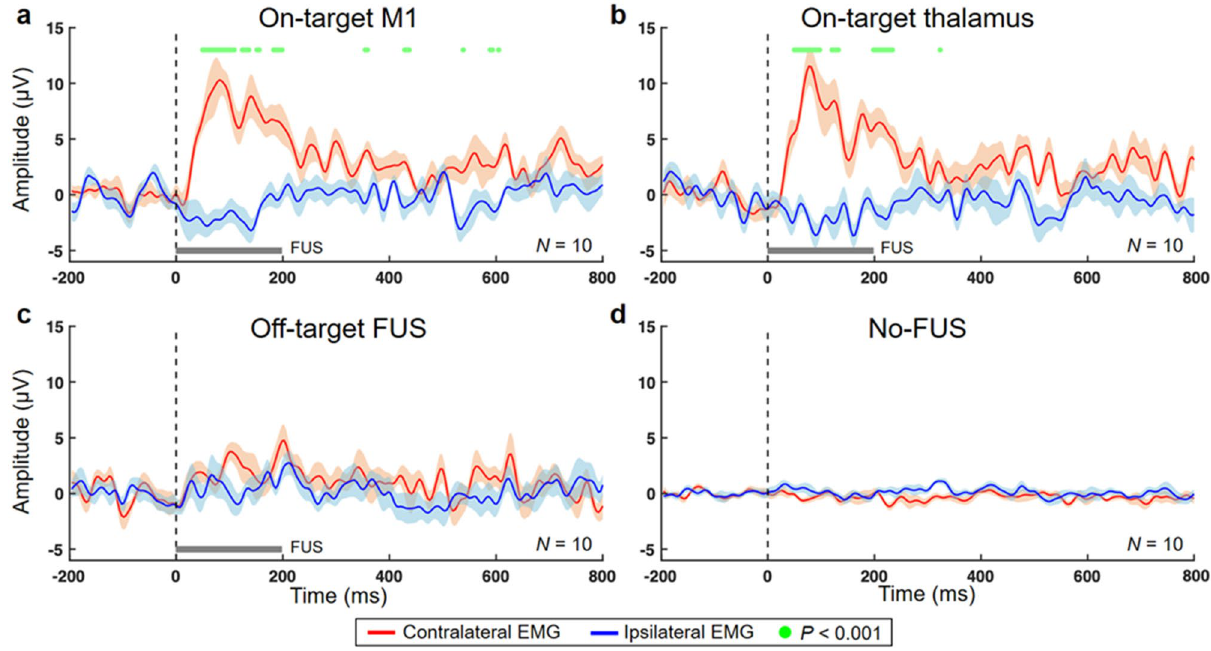
Figure 4. Comparison of time-locked EMG amplitudes between the hind limbs. The group-averaged EMG amplitudes measured from the hind limbs contralateral (red line) and ipsilateral (blue line) to 200-ms sonication (gray bar) were plotted (line: average across N = 10 sheep, shaded areas: standard errors) from stimulation of ( a ) the M1, ( b ) the thalamus, and ( c ) off-target area. ( d ) The same plot representing the no-FUS condition is shown. The green dots indicate significant differences (paired t- test, P < 0.001) in the EMG amplitudes between the hind